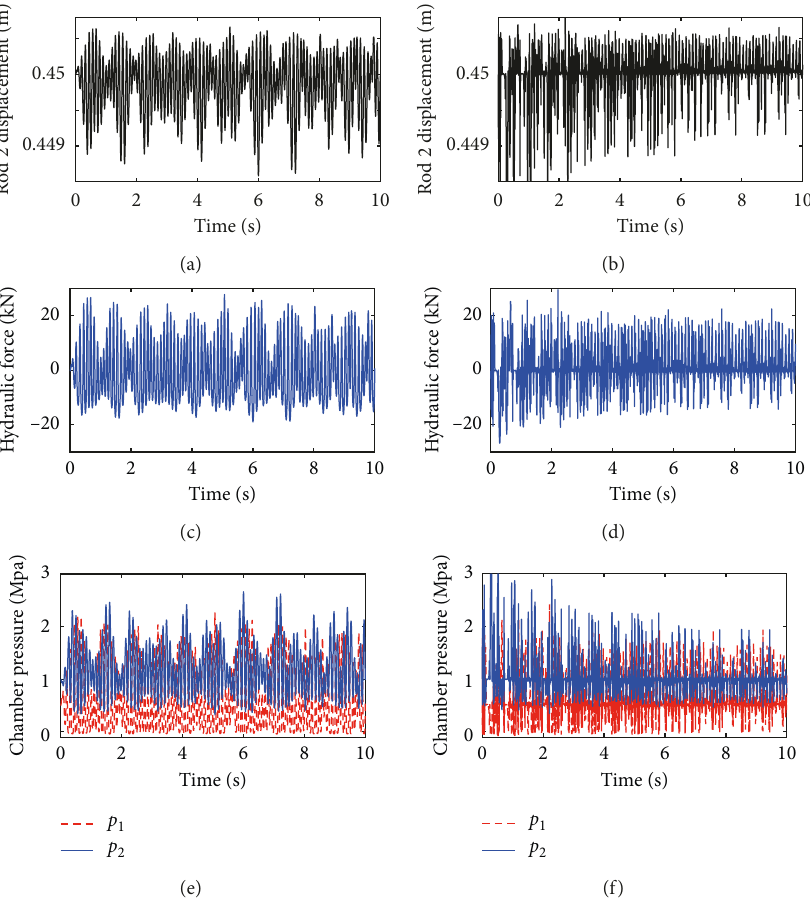
F IGURE 6: Differences in loads and displacements for the ideal and clearance models: rod 2 displacement x and hydraulic chamber pressure p 1 / p 2 of the hydraulic cylinder in the ideal model (a, c, e) and clearance model (b, d, f).